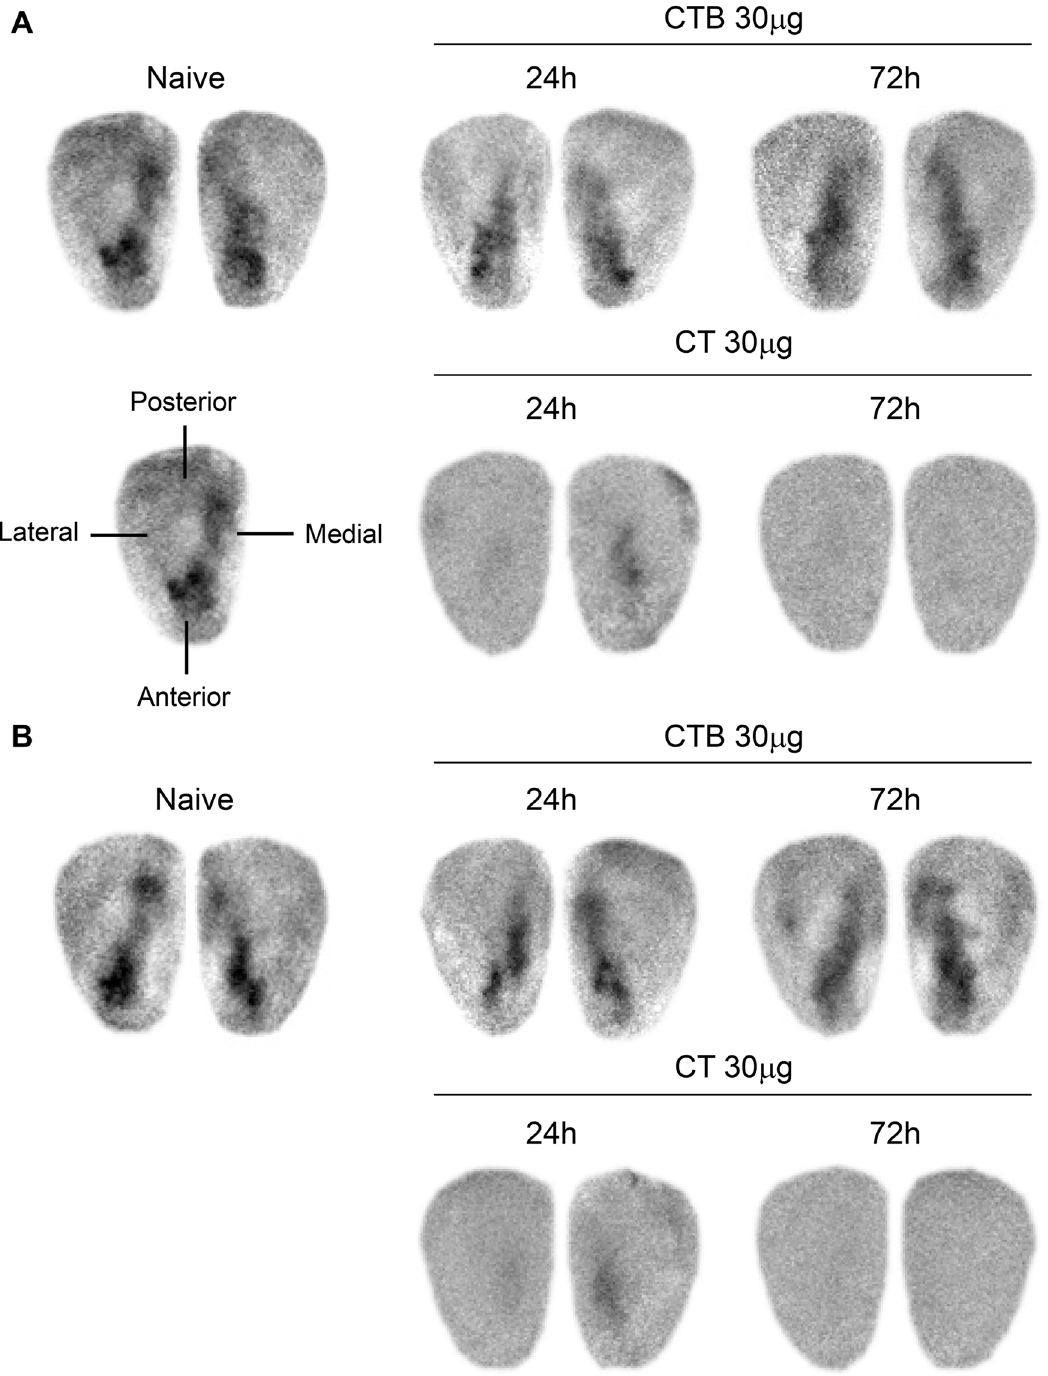
Fig 4. Optical imaging of intrinsic signals in response to odorant stimulation recorded from the dorsal surface of the OB. Spatial distribution of the response to stimulation with propionic acid ( A ) and valeric acid ( B ) recorded from the right and left OBs in na ï ve mice, or 24 or 72 h after nasal administration of 30 μ g of CTB or CT. Data are representative of three independent experiments ( n = 3 mice).